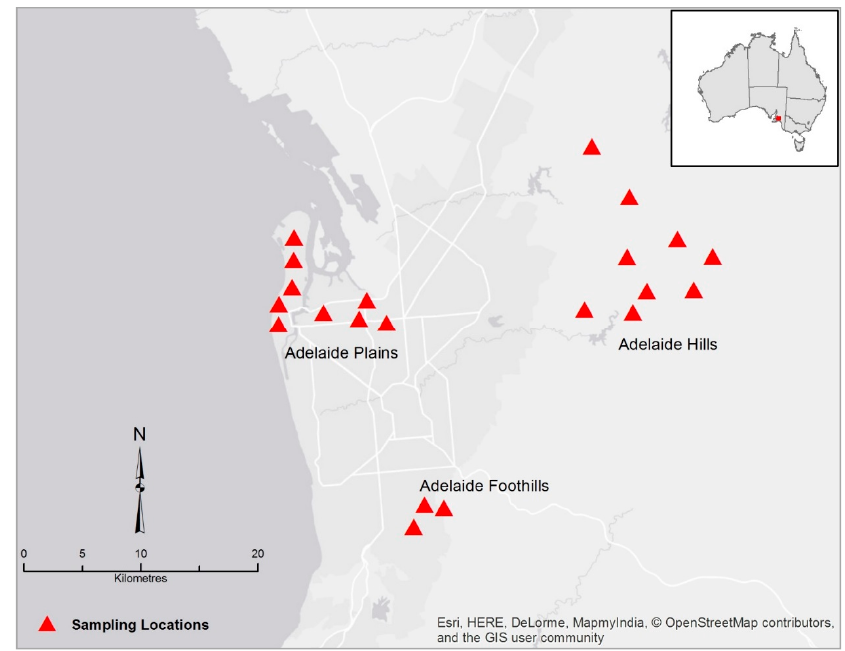
Figure 1. Study area, Adelaide region. The geographical spread of a study corridor is illustrated by the number Δ , this does not correlate to number of samples. ESRI Map Data, Delorme maps 2018.